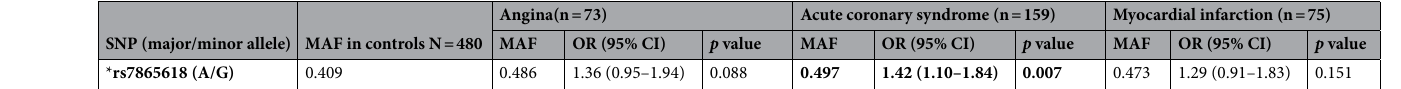
Table 4. Association of variants at 9p21.3 chromosomal region with stable/unstable angina, ACS, and MI categories. *Significantly associated in the sample of pooled CAD cases. Bold indicates the details of significant risk confering SNP.